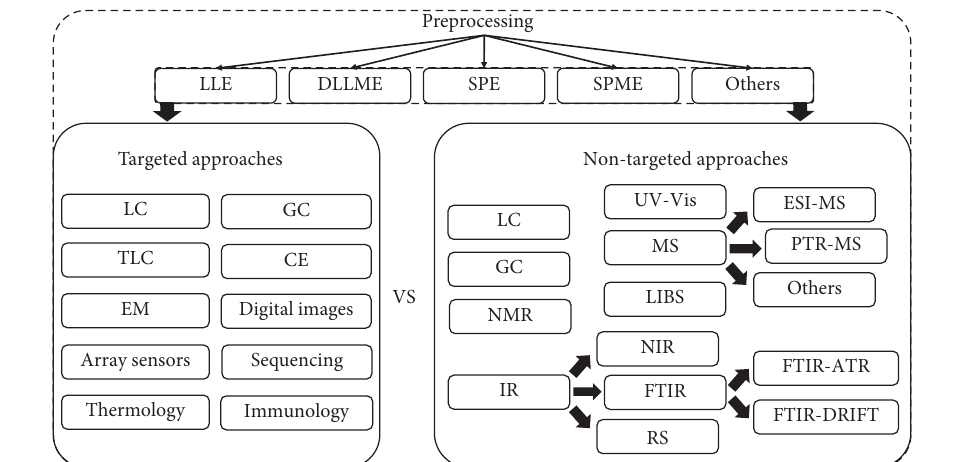
Figure 1: Diferent quality issues in cofee.